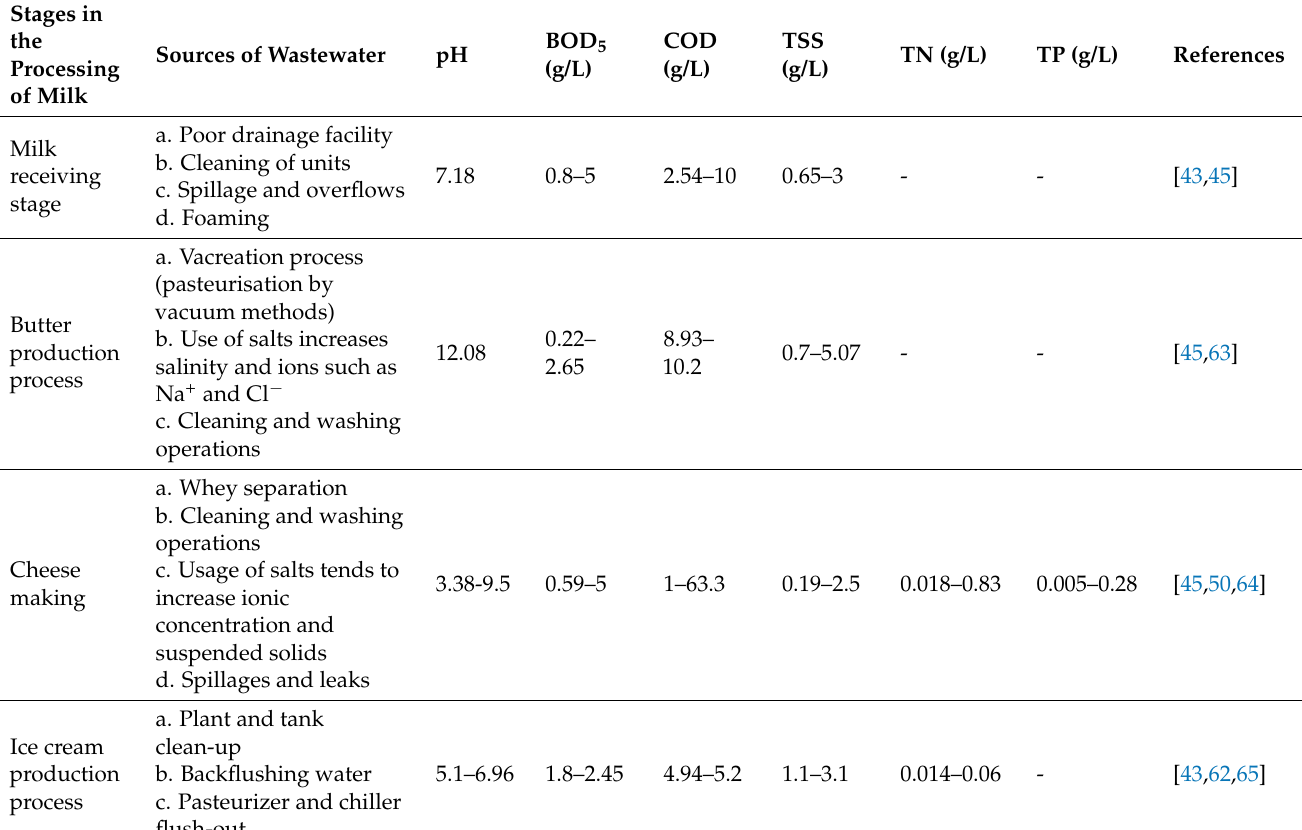
Table 2. Characteristics of dairy effluent at various stages of milk